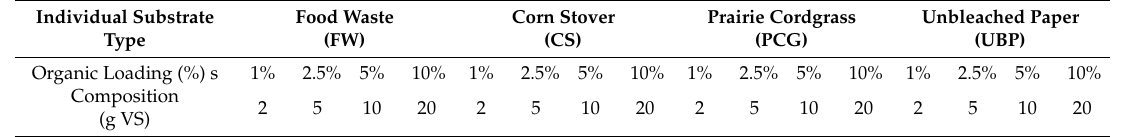
Table 2. The feedstock composition in the batch tests with individual wastes.